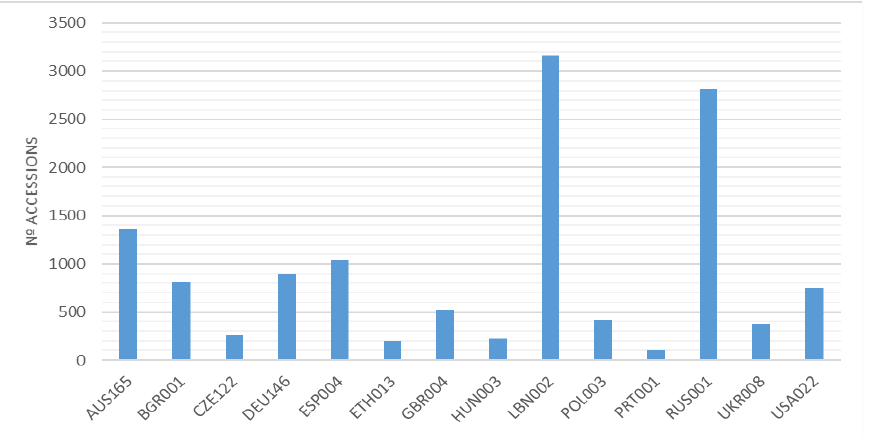
Figure 4. Main collection of Vicia sativa accessions, by holding institution, reported at GENESYS. The holding institutions are identified by their WIEWS code, available at https://www.fao.org/wiews/data/organizations/en; (accessed on 15 February 2023).